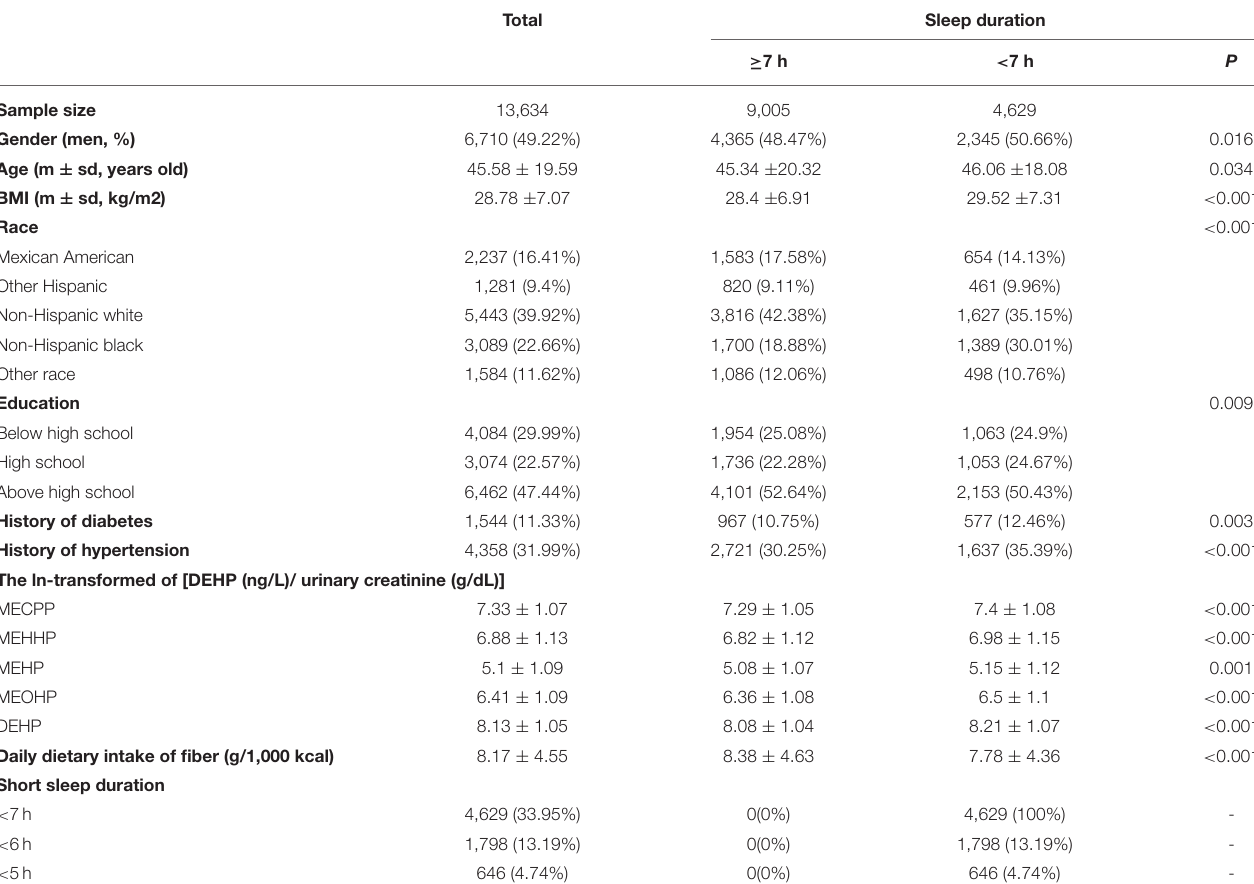
TABLE 1 | The characteristics and concentration of urinary DEHP metabolites in the included